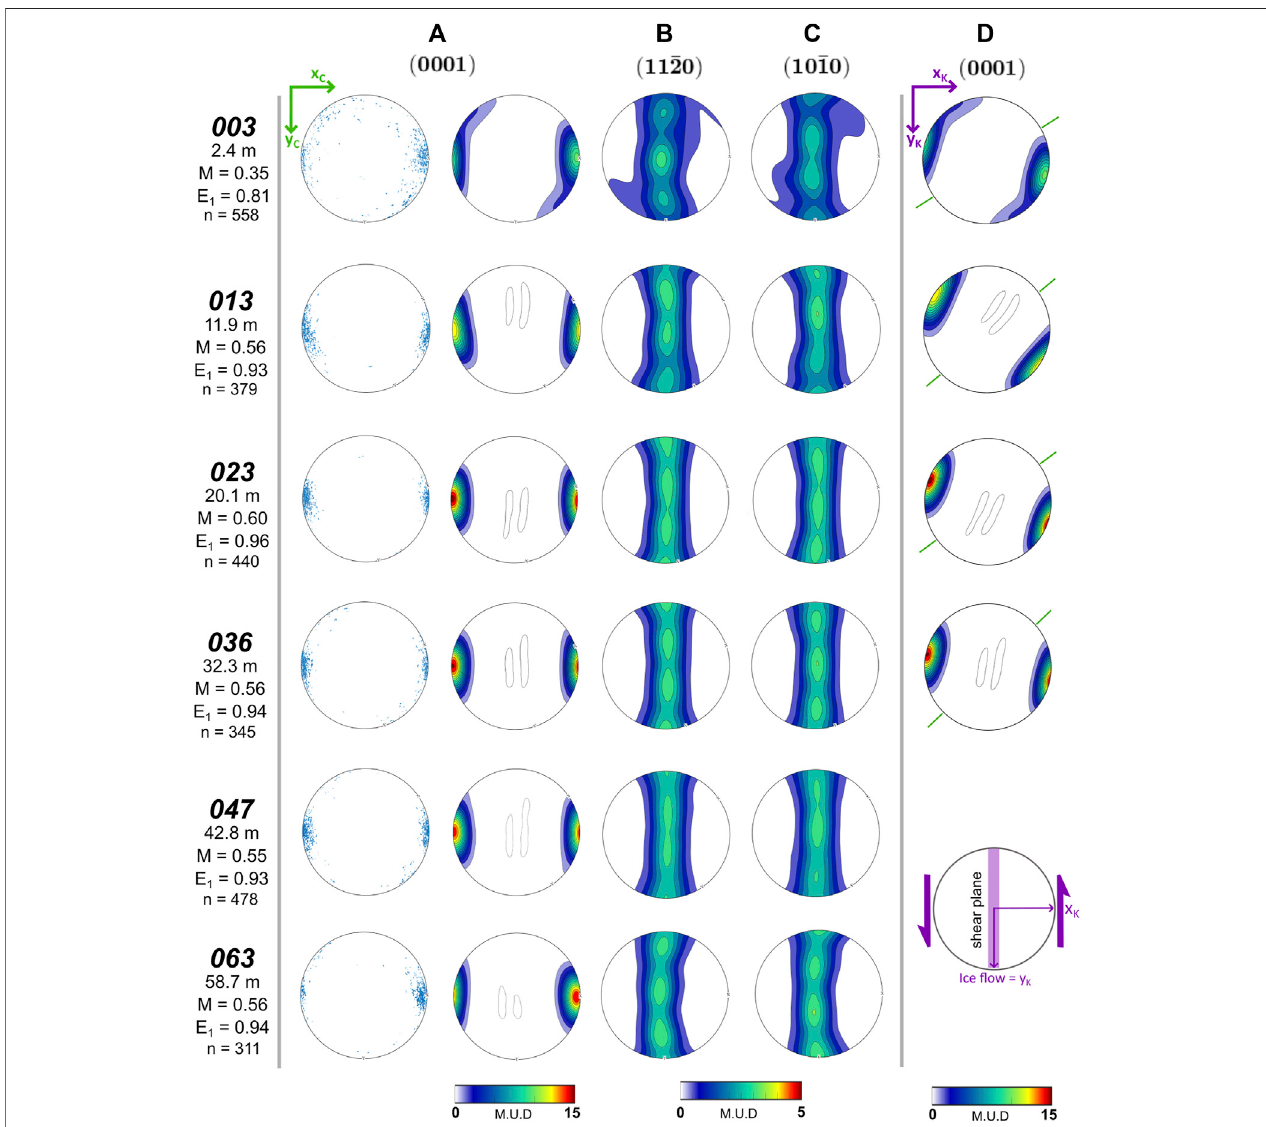
FIGURE7| Crystallographicpreferredorientationsforsixrepresentativesamplesorientedinthe “ c -axismaximum ” referenceframe.CPOsfor (A) c-, (B) a-and (C) m-axes, M index and c -axis eigenvalues (for de fi nition see section 4.6 ) are calculated from orientation data. CPOs are also arranged in the “ kinematic ” reference frame (D) ,withtheexceptionofsamples047and063,whichareunoriented.Orientationsoflayertracesobservedinsamplethinsectionsarede fi nedbygreenticksonthepole fi gures. The intensity of a fabric is given as the multiple of uniform density (M.U.D), and is calculated from the maximum intensity of a contoured pole fi gure. M.U.D values of 1 would indicate a random fabric with no preferred